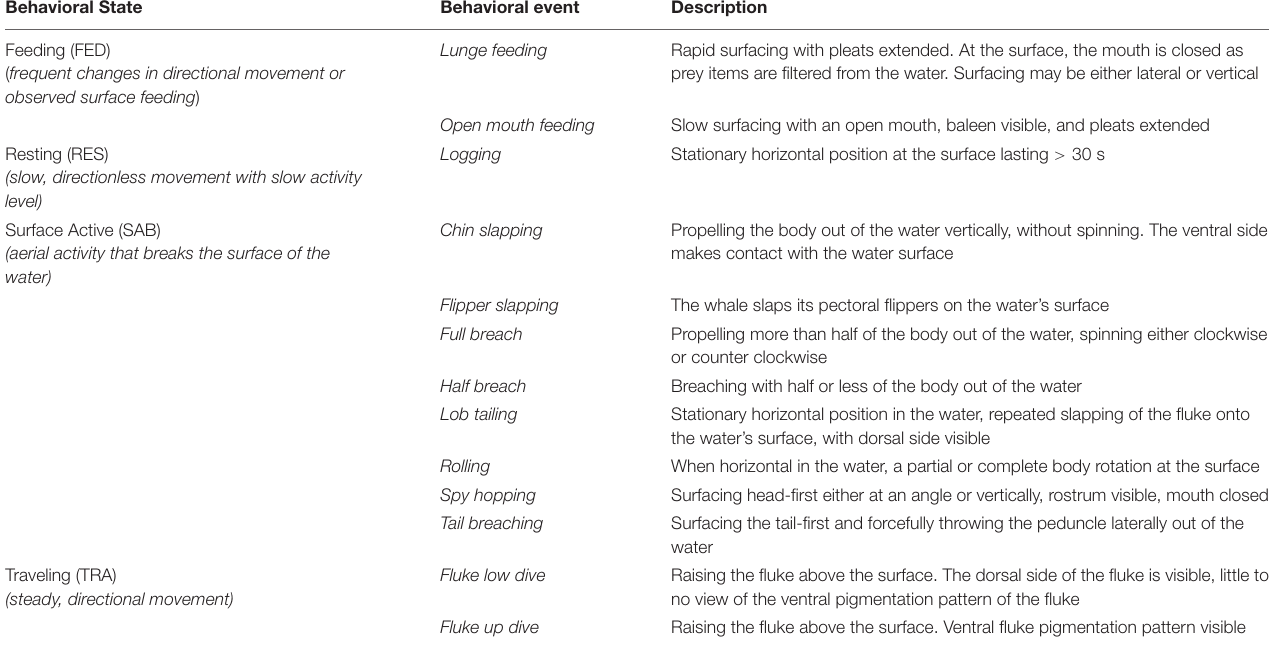
TABLE 2 | Behavioral ethogram for observations of humpback whales in Juneau. Behavioral State Behavioral event